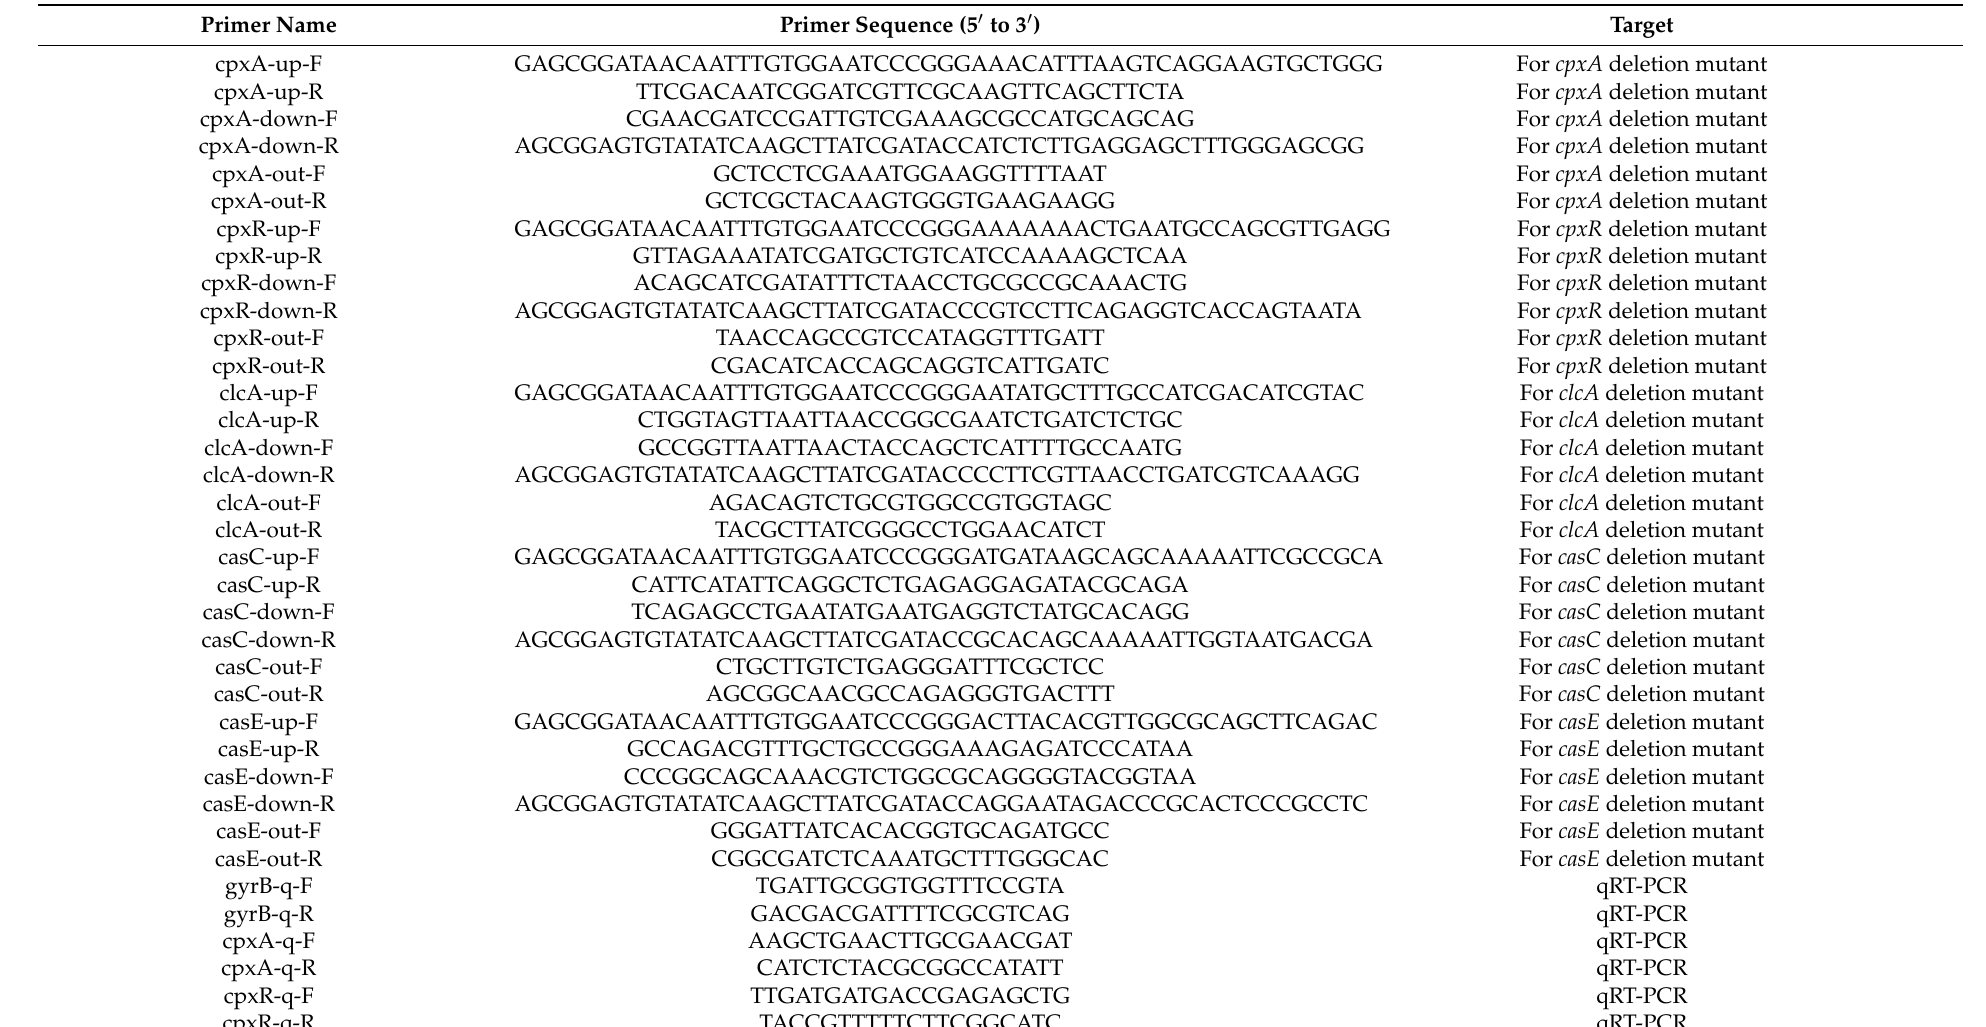
Table 2. Primers used in this